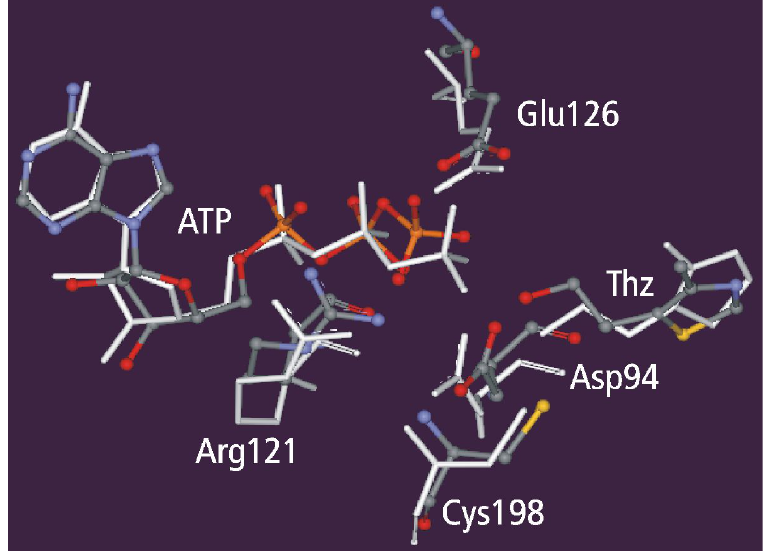
Figure 2. Superimposition of MM optimized ThiK active site fragments (substrates and the side chains of the most important amino acid residues). The model containing one magnesium ion is presented in stick representation, white colour. Only heavy atoms of all molecules are